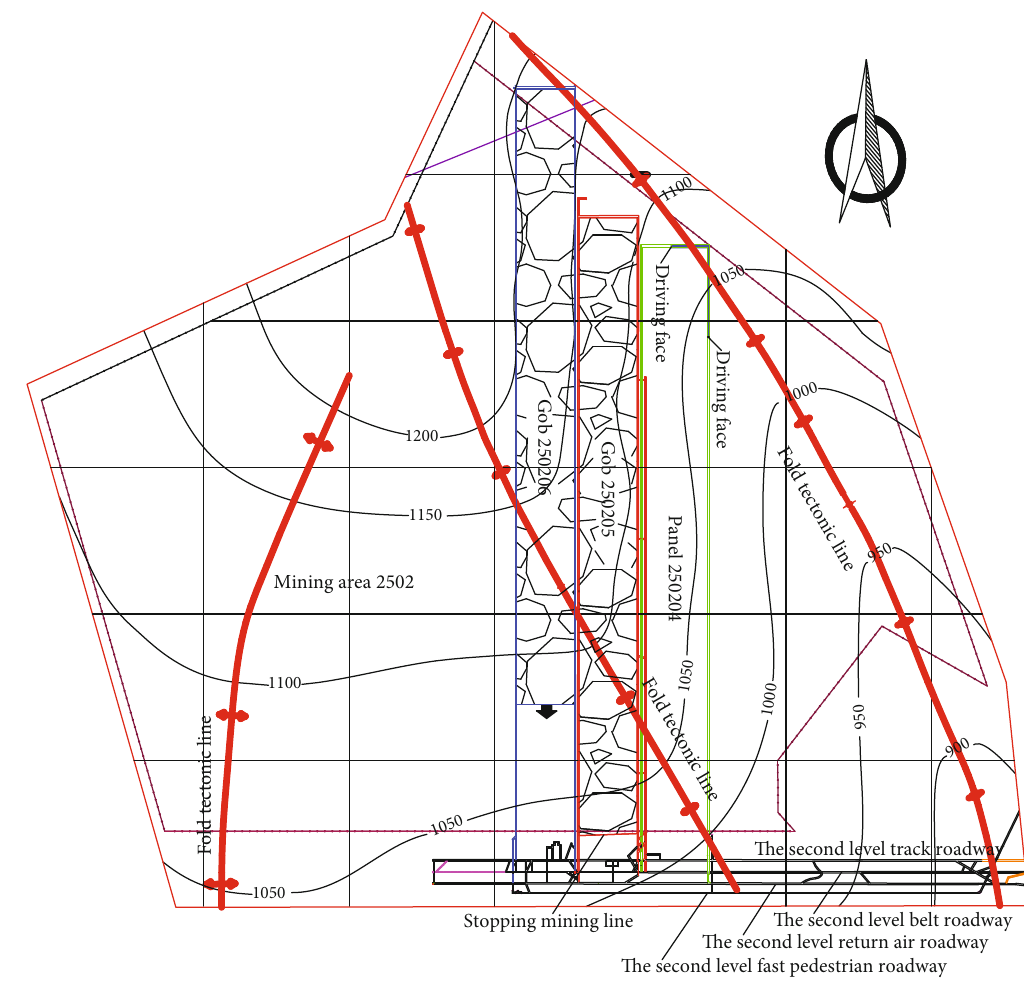
Figure 3: The plan of mining and driving engineering in mining area 2502. Table 1: The coal-burst tendency judgment